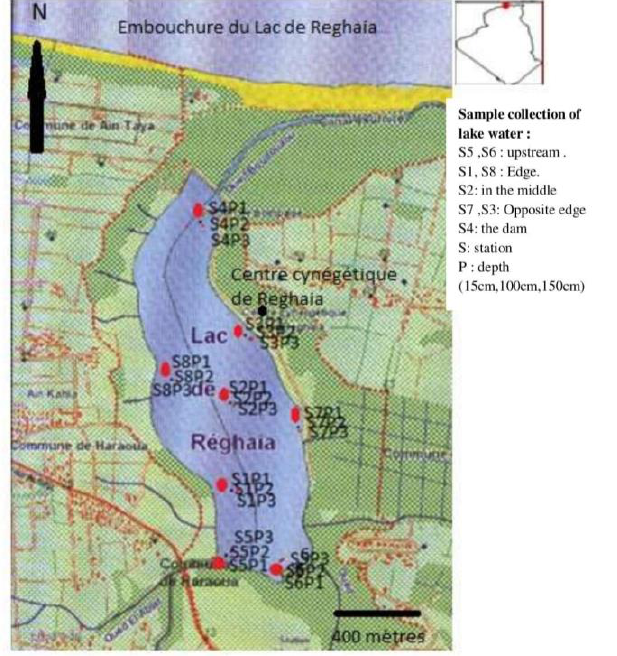
Figure 1. Map of the Lake of Reghaia and sampling locations. S5, S6 (upstream); S1, S8 (Edge); S2 (in the middle) S7, S3 (Opposite edge) S4 (the dam); S (station); P (depth) (15cm, 100cm, 150cm) .